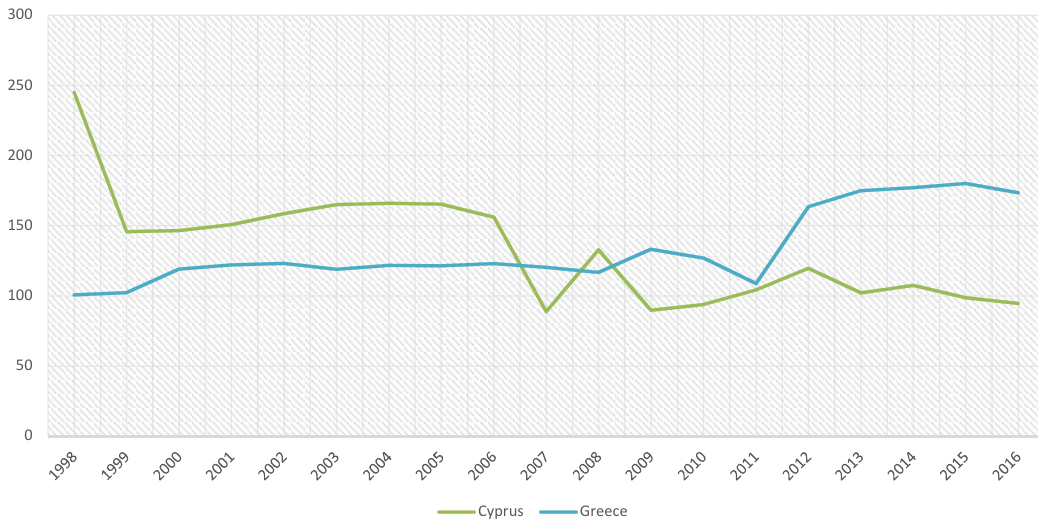
Figure 10. Greek and Cypriot government debt as % of